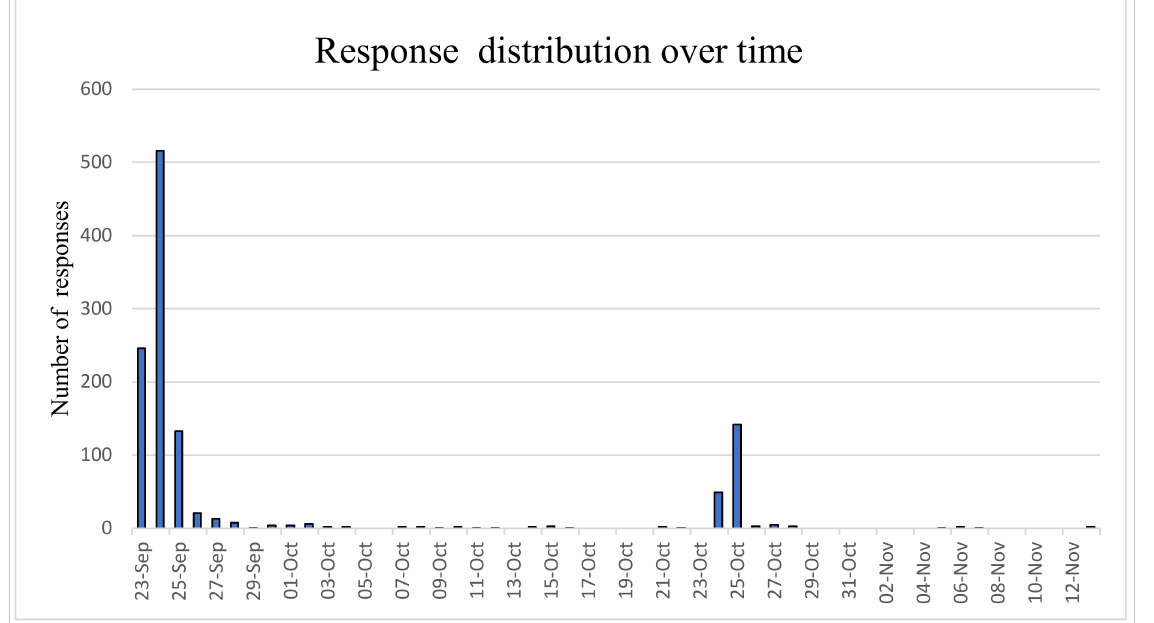
Figure 2. Distribution of responses over time: 1 ◦ peak during the academic year’s first week and 2 ◦ peak after the “recall” flyers